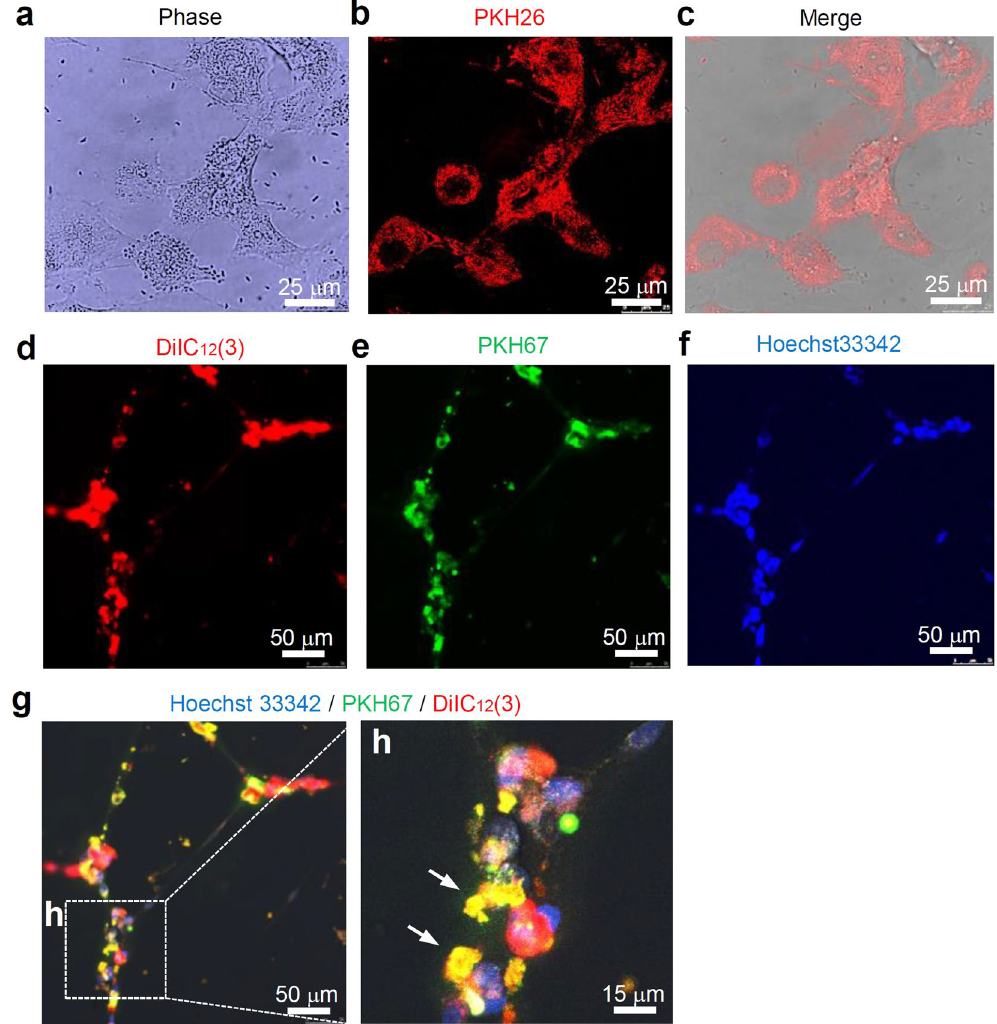
Figure 3. Angiogenesis imaging of HUVECs by the uptake of exosomes secreted from HepG2 cells. ( a–c ) The uptake of HepG2-exosomes labeled with PKH26 by HUVECs. These figures were imaged by confocal laser scanning microscopy. ( d–h ) The internalization of the HepG2-exosomes in the lumens formed by HUVECs. The membranes and nuclei of HUVECs were labeled with DilC 12 (3) and Hoechst33342, respectively. HepG2- exosomes were labeled with PKH67. White arrows show the HepG2-exosomes included in the HUVECs that formed lumen structures. These figures were imaged by confocal laser scanning